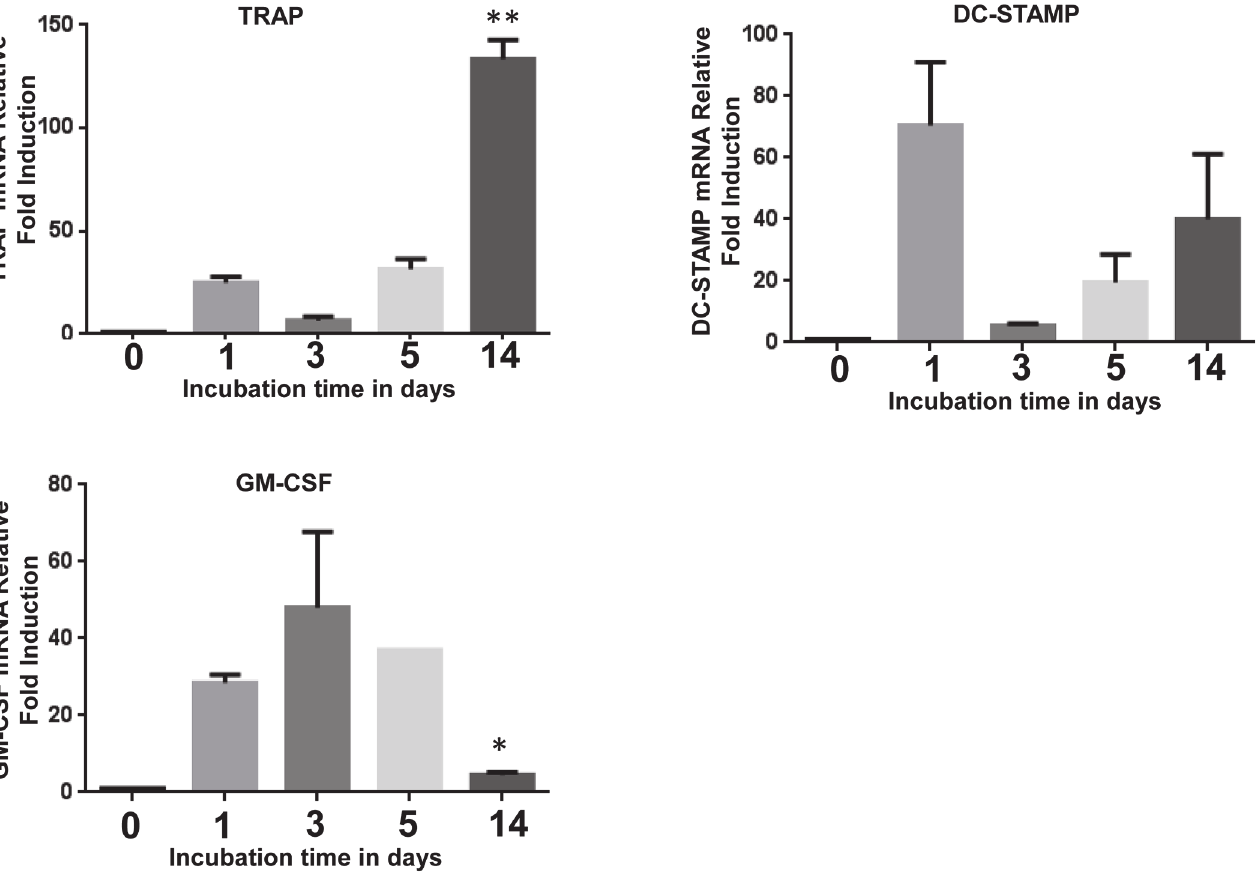
Fig 5. Elevated mRNA levels of TRAP, DC-STAMP and GM-CSF in day 14 co-cultures. Particles were added at the time of gel polymerization at the ratio of 10:1 particles to PBMCs. Endothelial cells (EA) were grown on the gel to form a monolayer. Peripheral blood mononuclear cells (PBMCs) were seeded either on top of the monolayer. Cells were harvested by digesting the gel with RNA extraction buffer and proceeded for RT-PCR as described in method. Each bar is represented as mean +/- S.E. of two experimental samples from two independent experiments, n = 2. * Asterisks indicate statistically significant TRAP and GM-CSF increase in particles exposed cells at day 14 compared with day0, ( ** = p < 0.005, * = p <